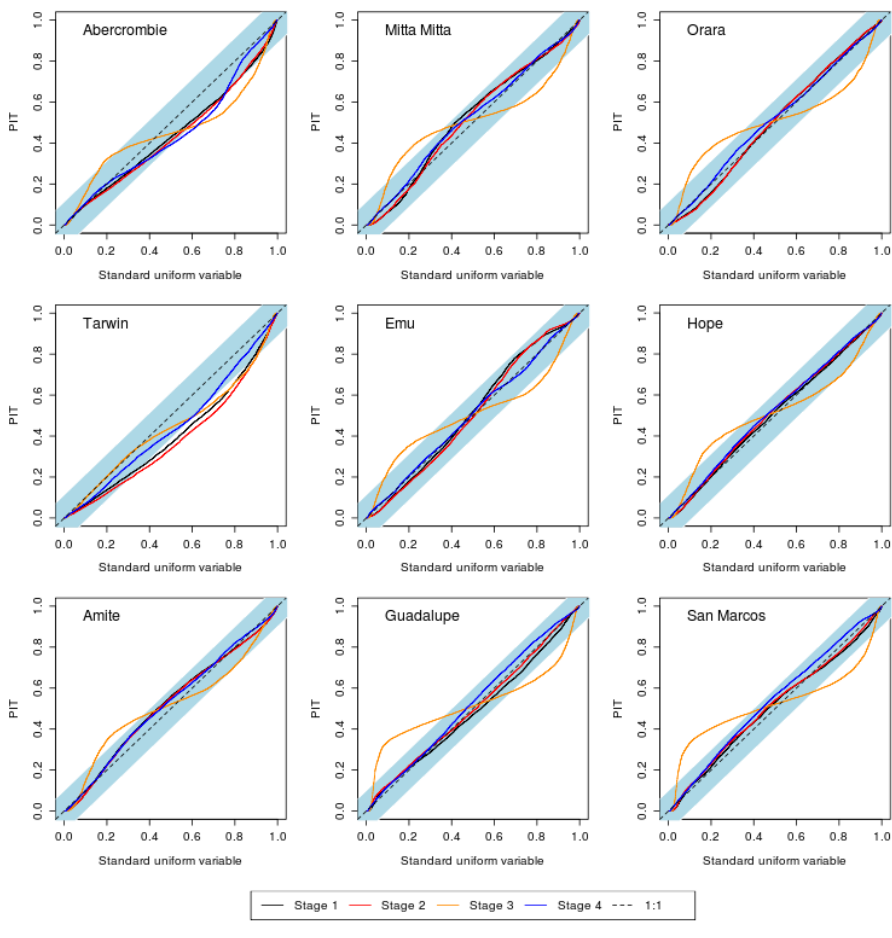
Figure 3. Comparison of performance metrics for each catchment and each